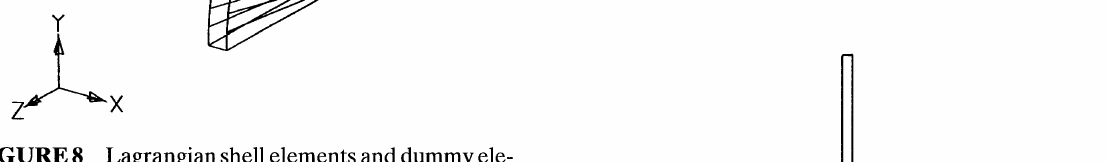
FIGURE 8 Lagrangian shell elements and dummy ele ments for the infinite cylinder/plane step wave problem.